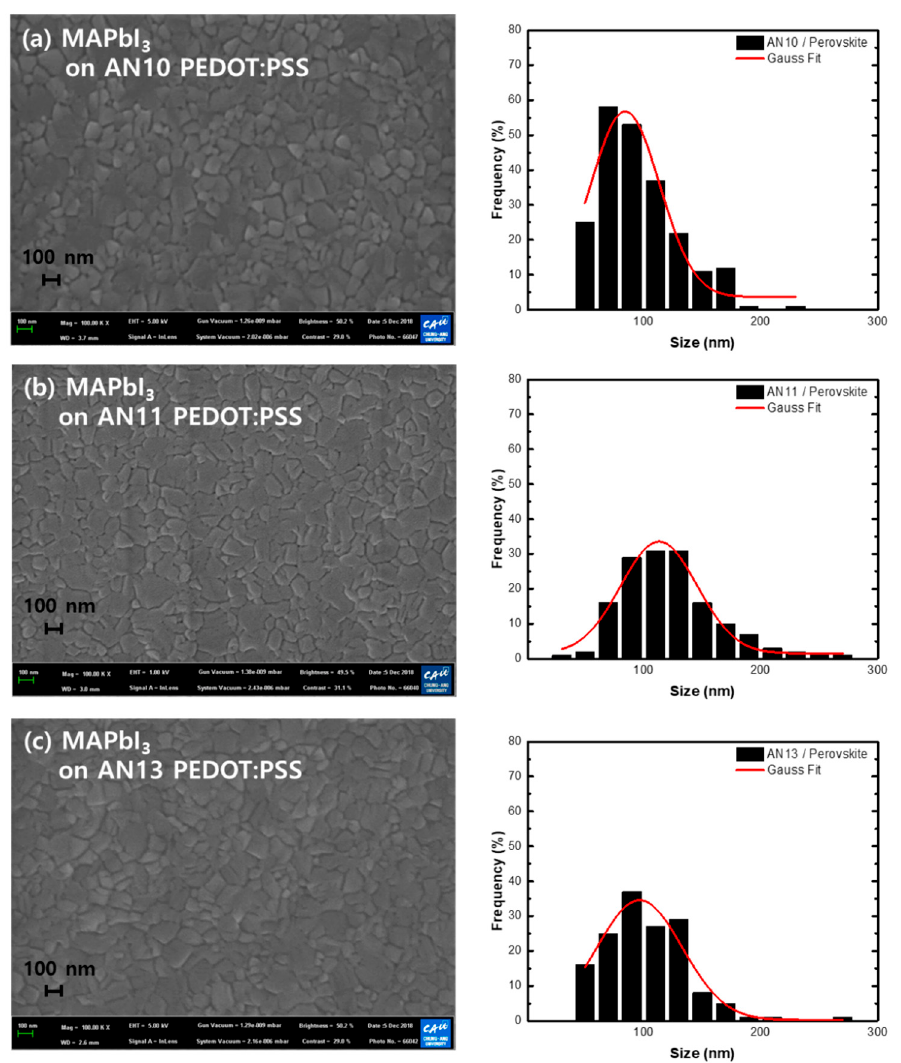
Figure 5. FE-SEM images of MAPbI 3 crystals formed on thin films with different ratios of acidic and neutral PEDOT:PSS: ( a ) AN10, ( b ) AN11, and ( c ) AN13.